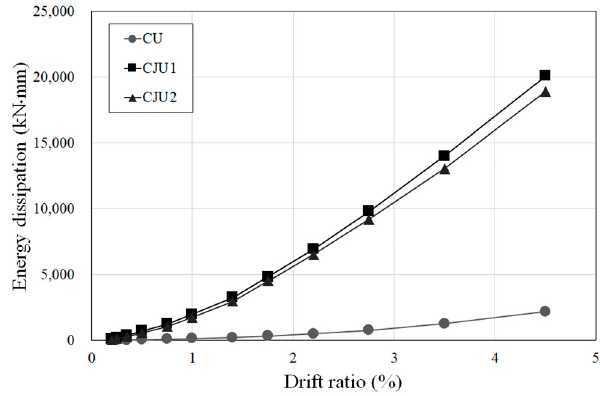
Figure 10. Cumulative dissipated energy for all